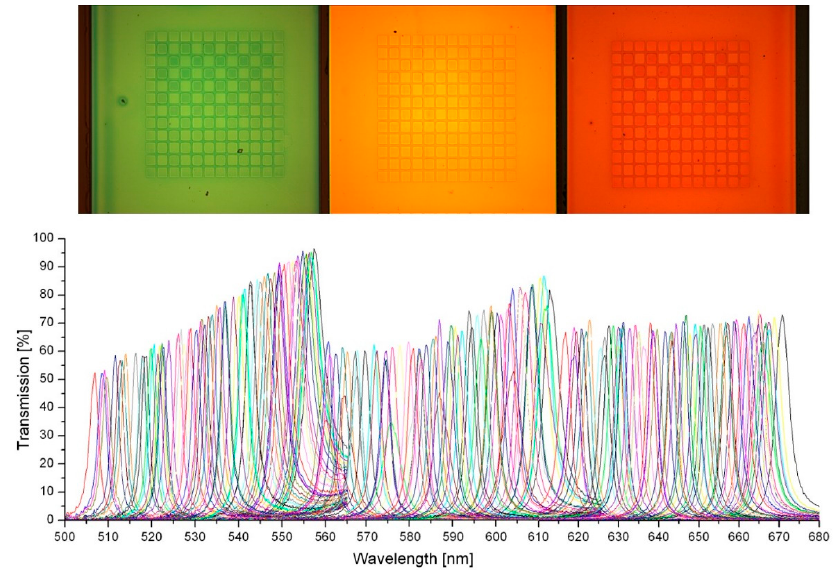
Figure 4. Optical microscope image of three FP filter arrays with corresponding optical transmis- sion spectra below. Reproduced with permission from [36] © Springer Applied Nanoscience,